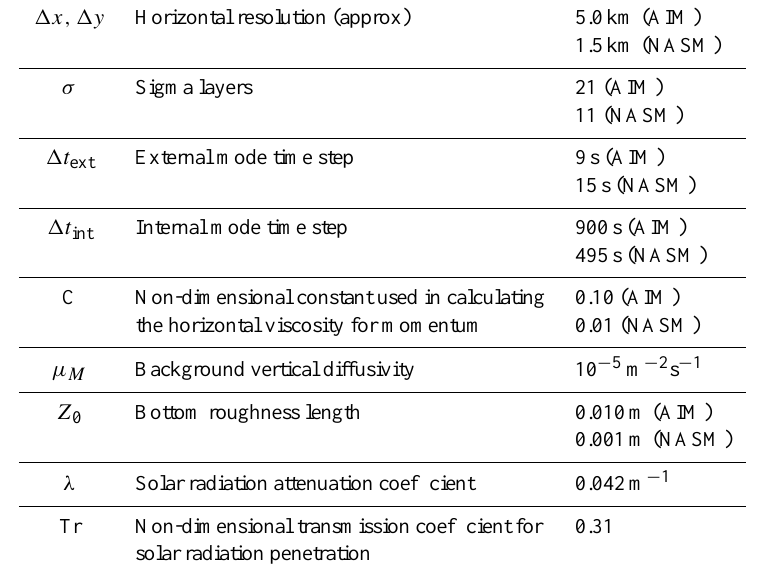
Table 2. The AIM and NASM implementation